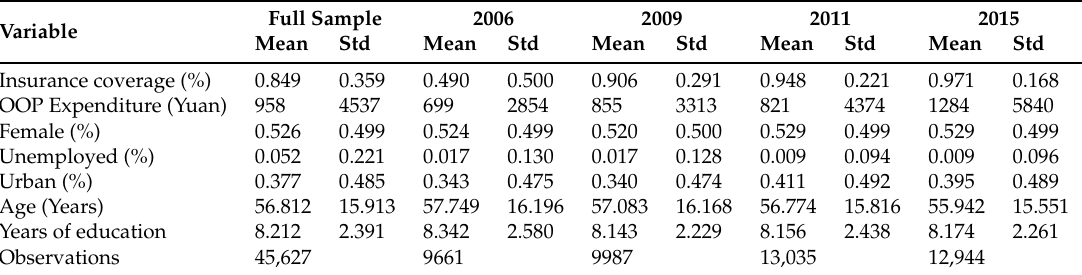
Table 4. Summary statistics of key variables.